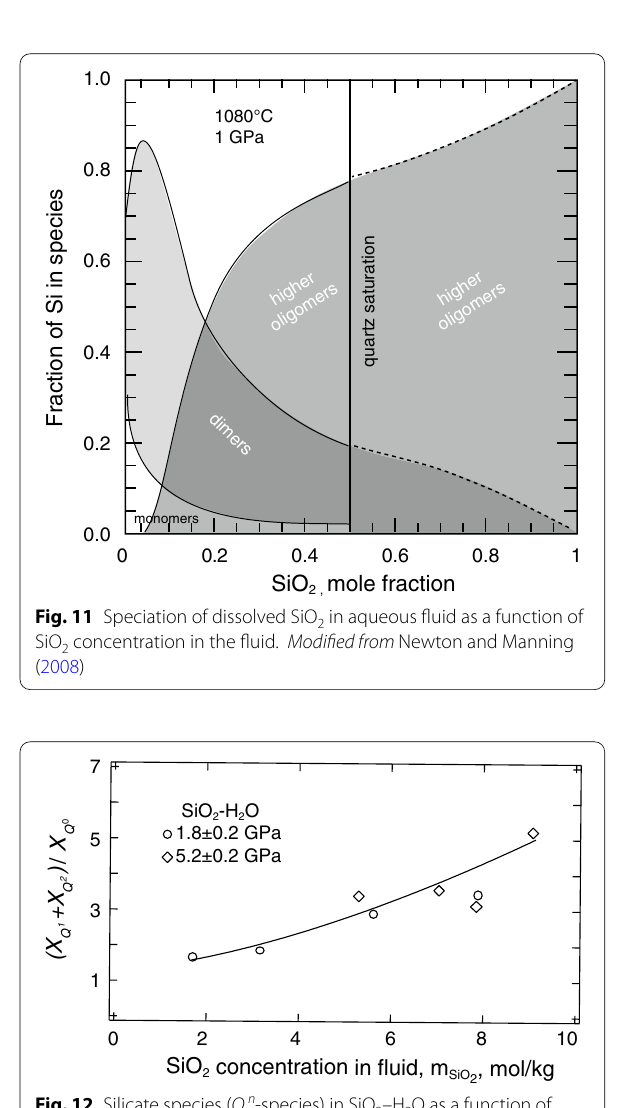
Fig. 12 Silicate species ( Q . n -species) in SiO 2 –H 2 O as a function of total SiO 2 concentration at temperatures and pressures indicated. Modified from Mysen et al. (2013)